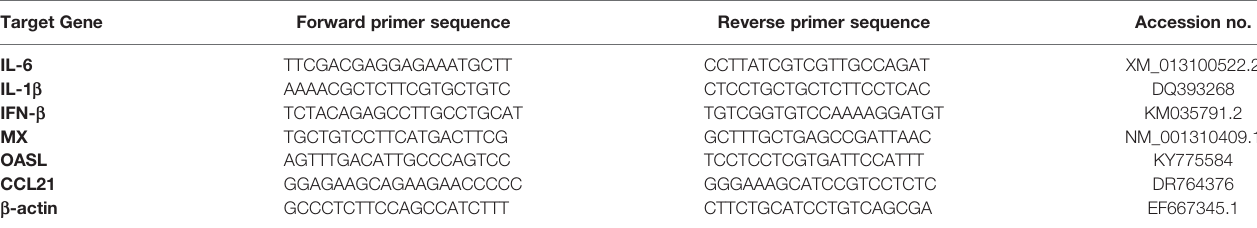
TABLE 1 | Primers for RT-qPCR analysis of gene expression. Target